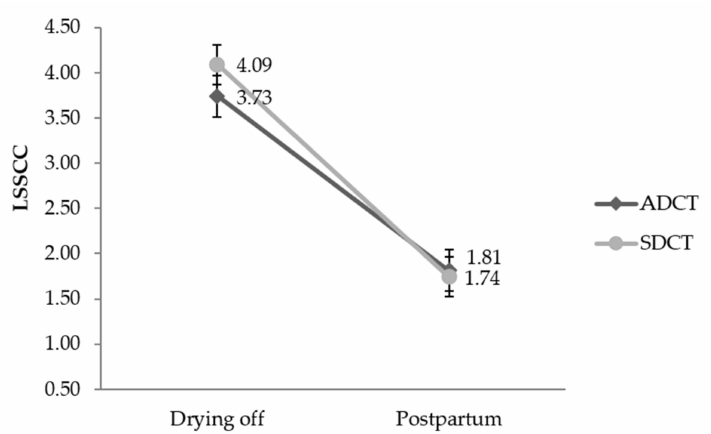
Figure 1. Descriptive results of mammary quarters SCC of samples collected at drying o ff and postpartum (mean and standard deviation) according to the treatment groups evaluated. p -value: Treatment: p = 0.292; Time: p < 0.001; Treatment vs. Time: p = 0.005; Days in milk: p = 0.0127; Parity: p < 0.0001. LSSCC: SCC transformed on linear score according to Schukken et al. [24]. ADCT: 0.25 g anhydrous cefalonium. SDCT: 0.25 g anhydrous cefalonium used in combination with ITS (bismuth